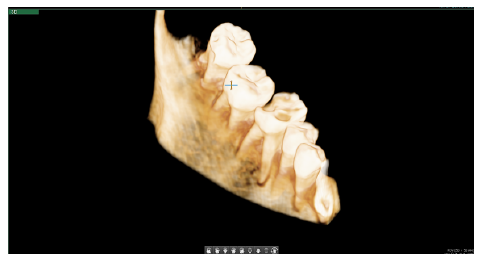
Figure 5. Higher resolution CBCT scan of mandible fragment part